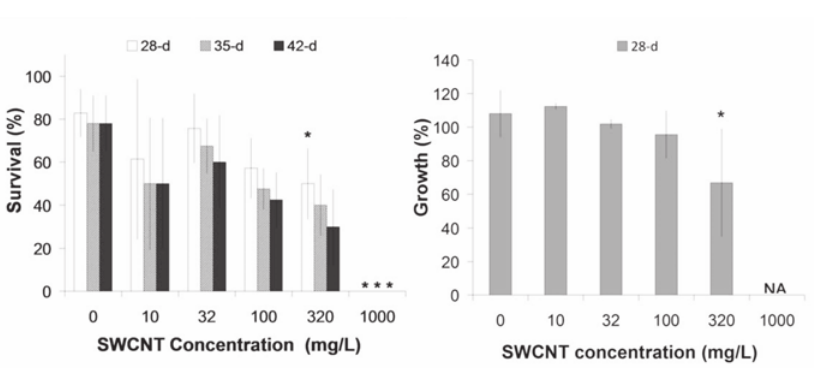
Figure 4. Mean survival and growth of Hyalella azteca exposed to different concentra- tions of single-walled carbon nanotubes (SWCNT) in M4 for 42 days. Survival of organ- isms after 28, 35 and 42 days of exposure and growth rate measured after 28 days of expo- sure. Each column is the mean of 3 to 6 replicates ± standard deviation and * indicates significant difference of group exposed compared to the